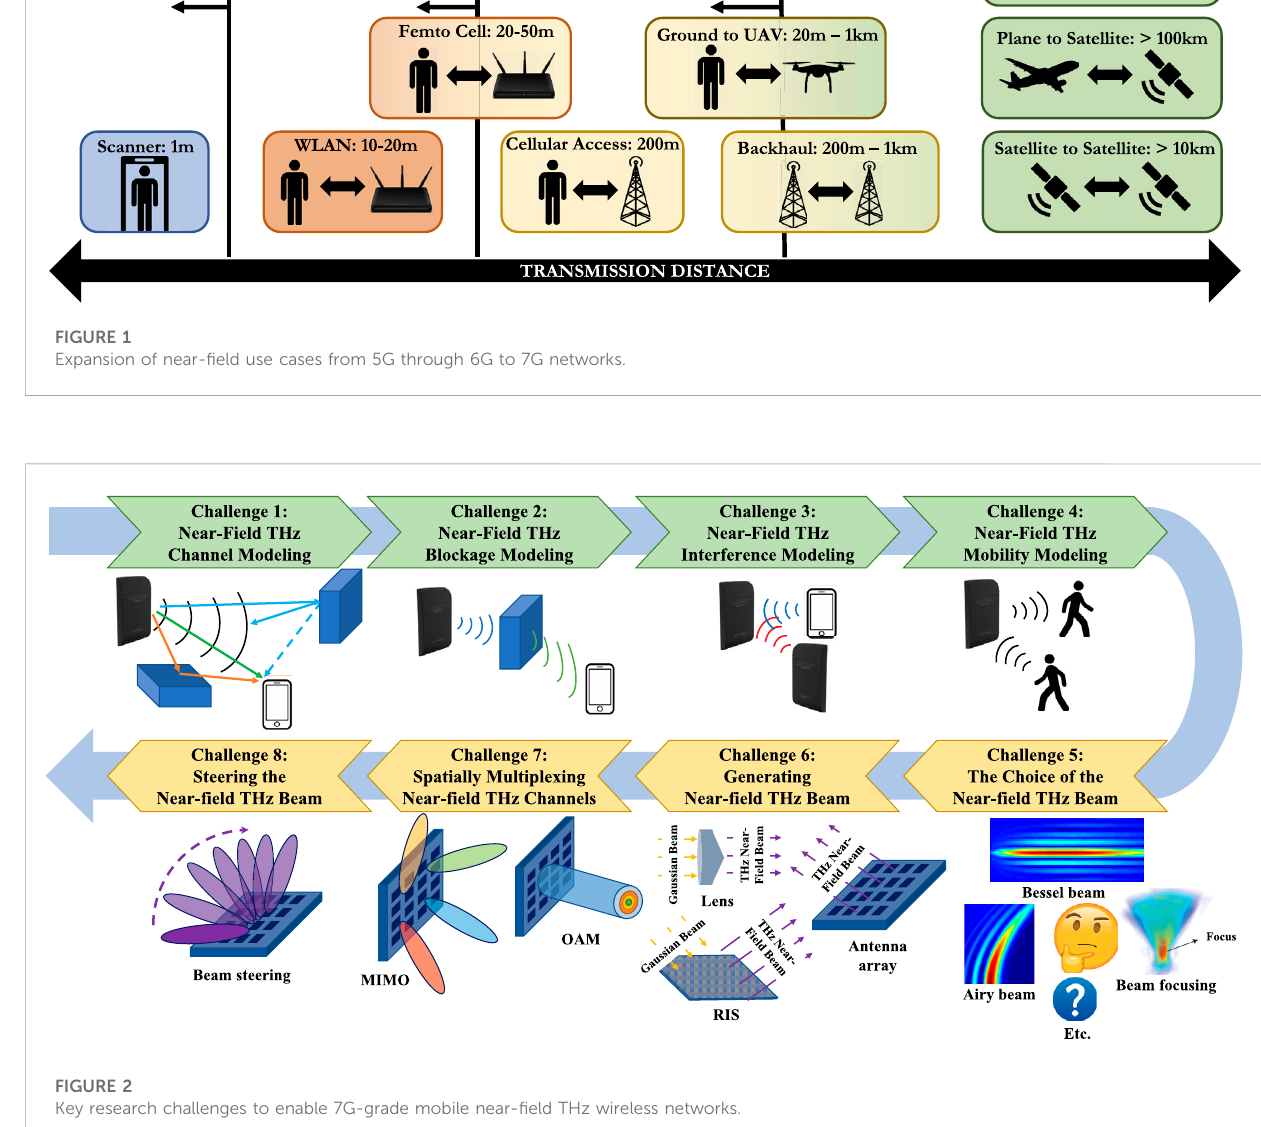
FIGURE 2 Key research challenges to enable 7G-grade mobile near- fi eld THz wireless networks.